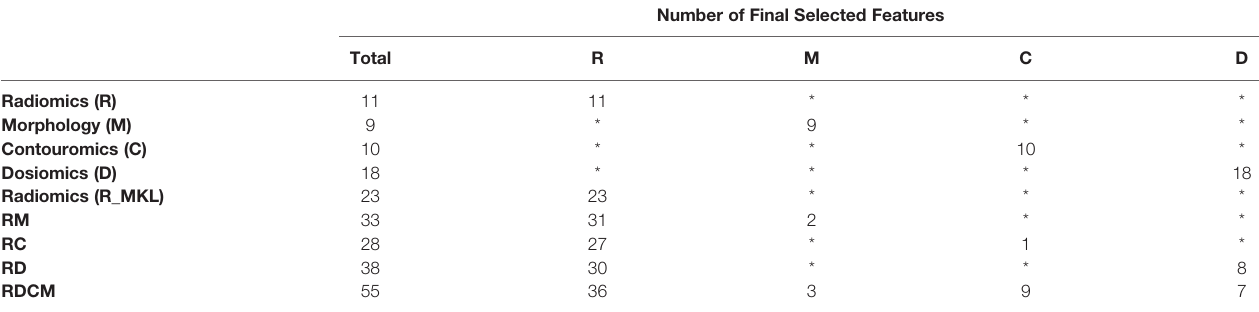
TABLE 3 | A summary of total number and distribution of selected features in the fi nal models.